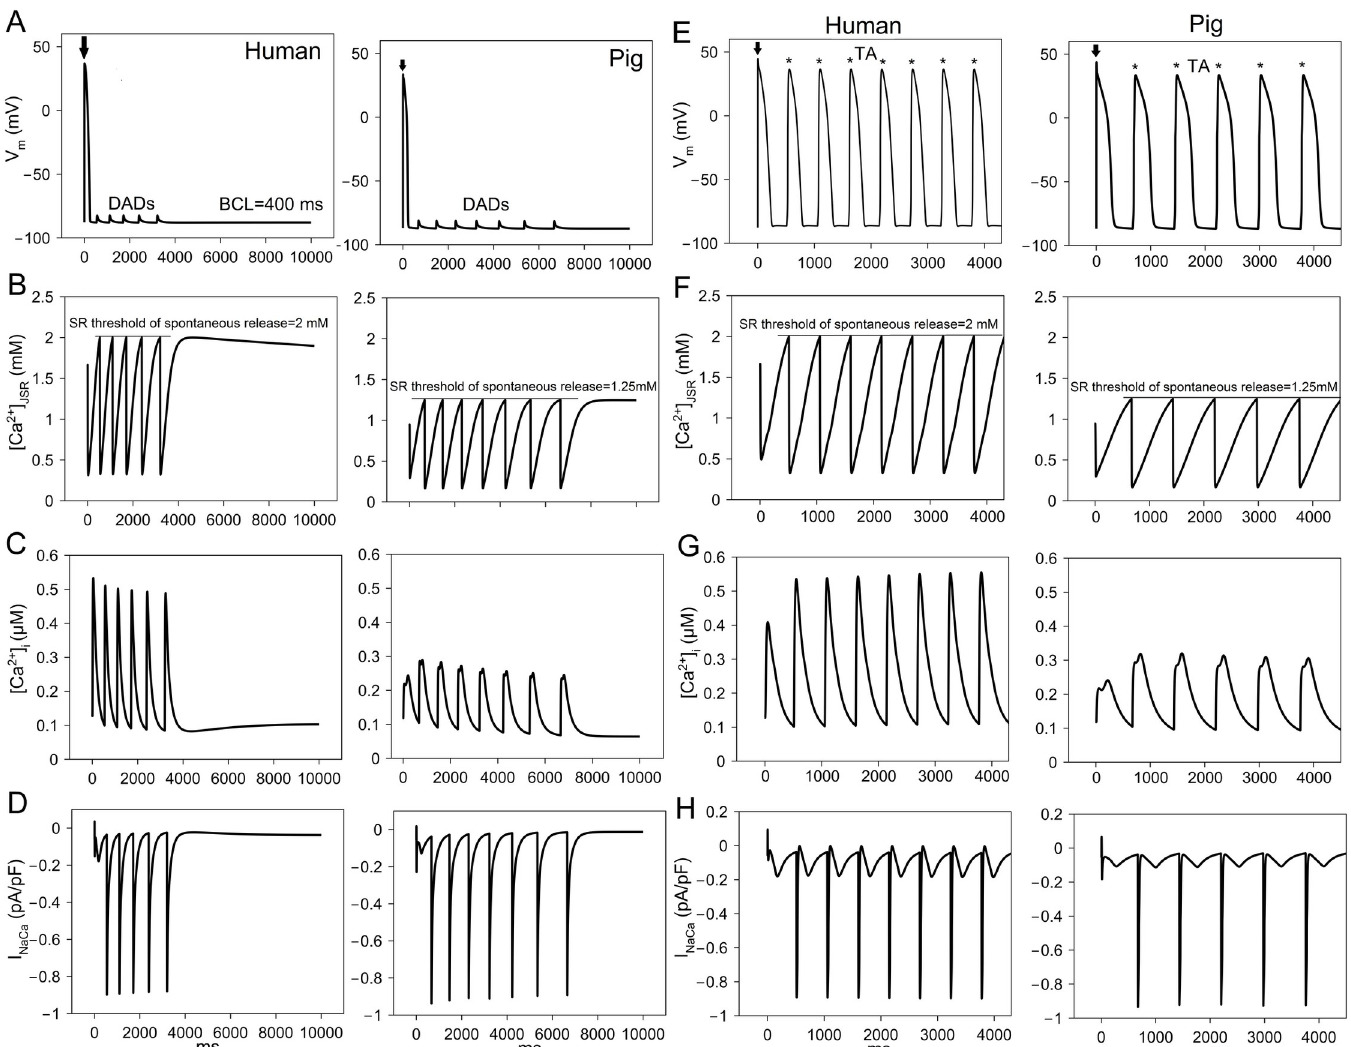
Fig 7. Delayed afterdepolarizations (DAD) formation in human and pig ventricular myocyte. (A) DADs in human and pig cells after cessation of pacing at cycle length (CL) = 400 ms. (B) Junctional sarcoplasmic reticulum (JSR) Ca 2+ concentration ([Ca 2+ ] JSR ). The threshold of spontaneous SR Ca 2+ release was 2 mM in human and 1.25 mM in pig. (C) Myoplasmic Ca 2+ concentration ([Ca 2+ ] i ). (D) Na + -Ca 2+ exchanger current (I NaCa ). (E) Triggered activity (TA) occurred in human and pig cell after cessation of pacing at cycle length (CL) = 400 ms. The fast Na + current (I Na ) activation was shifted leftwards by 10 mV in human and 15 mV in pig. In addition, the inward rectifier K + current (I K1 ) was reduced by 50% in the pig cell. The last paced beat is shown by an arrow. (F) Junctional Sarcoplasmic Reticulum (JSR) Ca 2+ concentration ([Ca 2+ ] JSR ). (G) Myoplasmic Ca 2+ concentration ([Ca 2+ ] i ). (H) Na + -Ca 2+ exchanger current (I NaCa ). The spontaneous SR Ca 2+ release threshold was 2 mM in human and 1.25 mM in pig. Lines show the threshold level at which Ca 2+ release